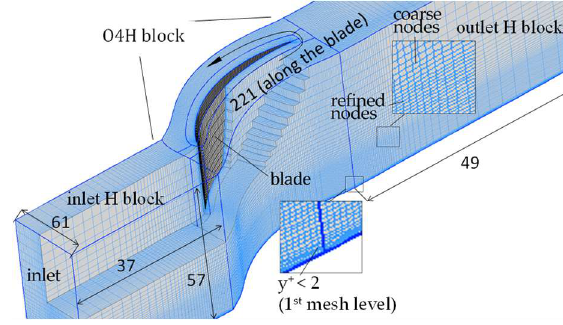
Figure 4. Overview of the